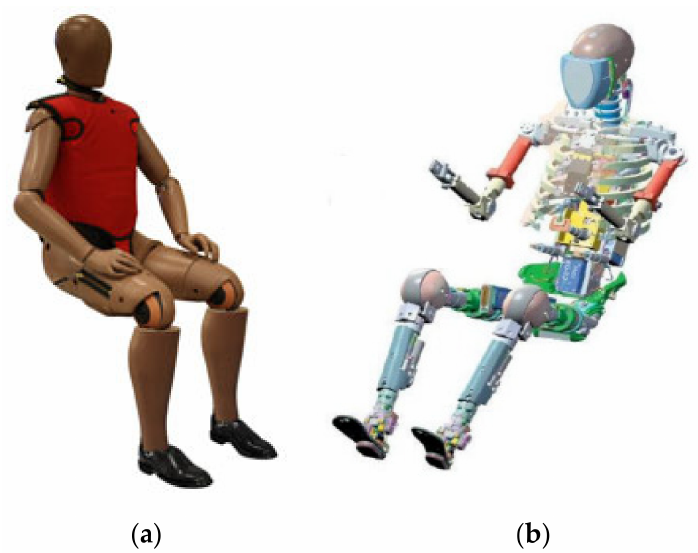
Figure 1. Anthropometric dummy for the THOR crash test [18]: ( a ) THOR-50th Dummy; ( b ) THOR- FT dummy CAD (Computer aided